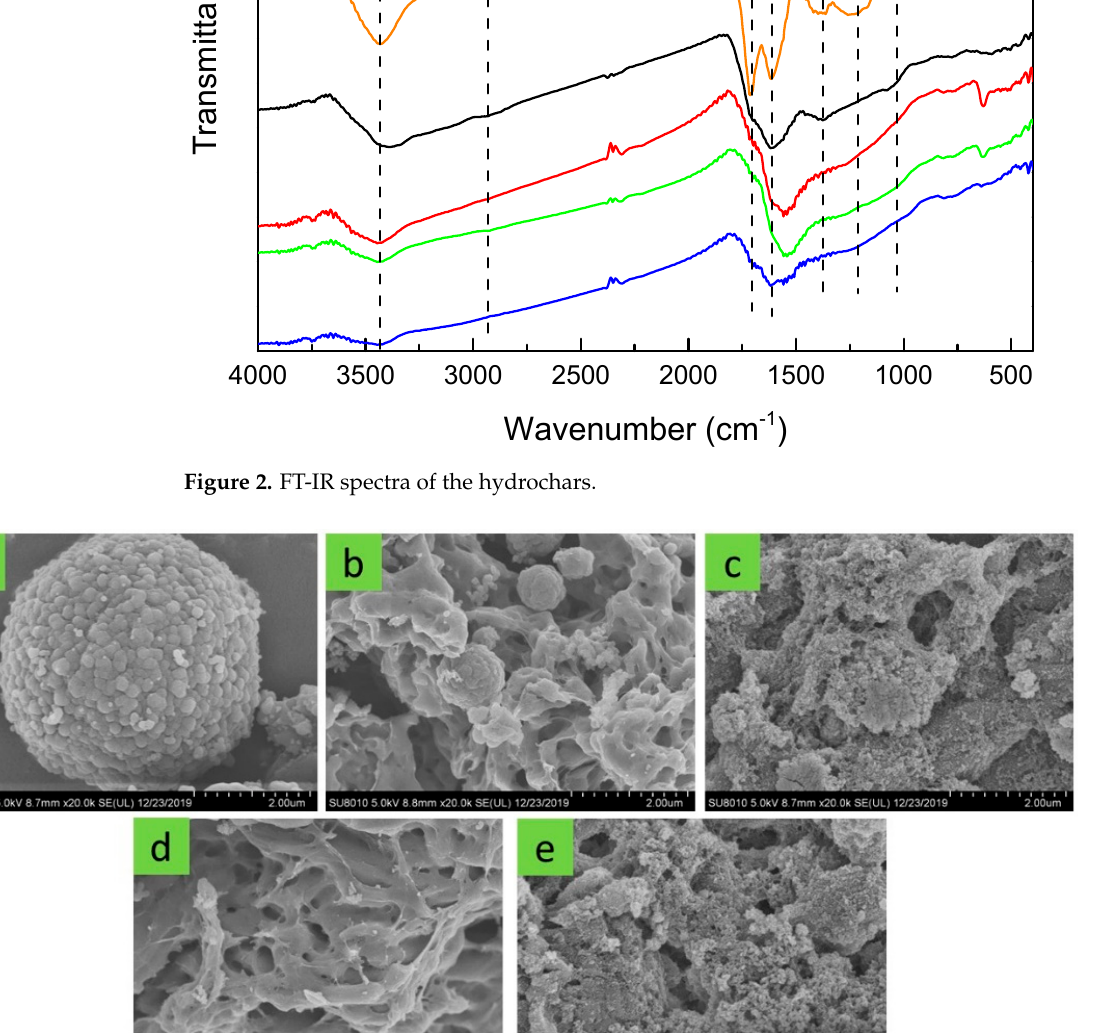
Figure 4. X-Ray diffraction patterns of hydrochar samples. 10